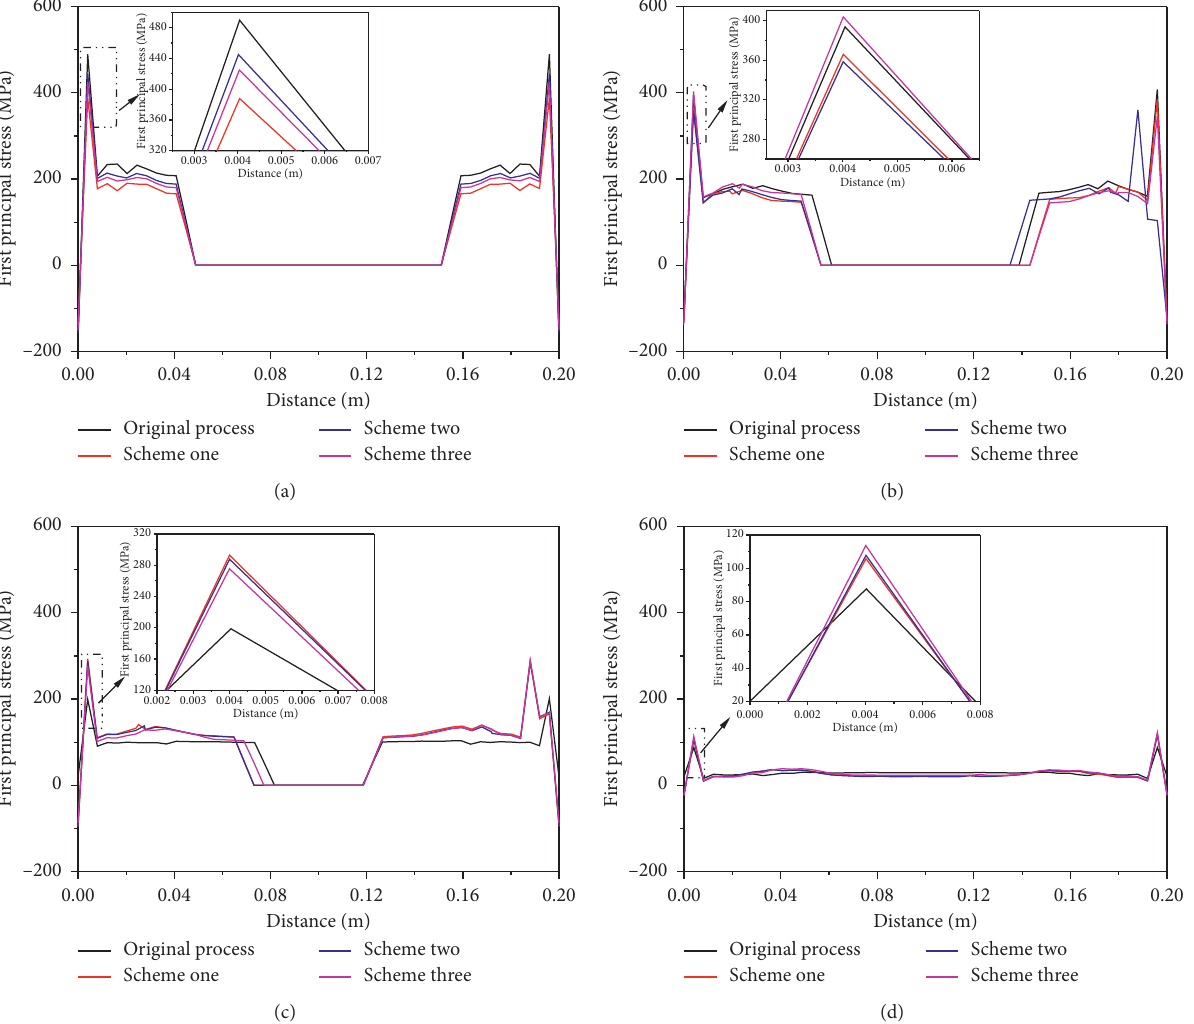
Figure 17: Comparison of the first principal stress at the narrow surface symmetric plane under different water distribution schemes. (a) Outlet of zone 2. (b) Outlet of zone 3. (c) Outlet of zone 4. (d) Outlet of zone